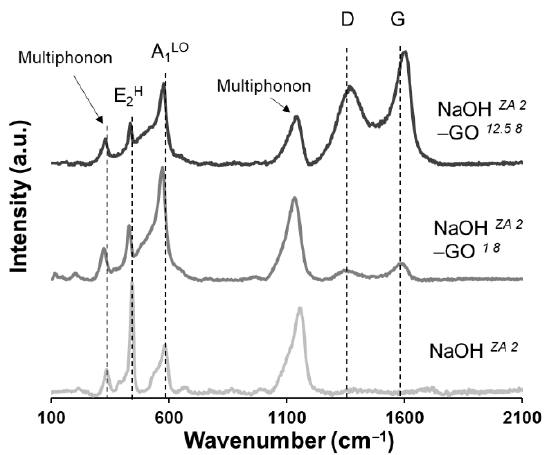
Figure 7. Raman spectra of ZnO (NaOH ZA 2 ) and ZnO – rGO composites with the addition of differ- ent GO concentration: 1 mg/mL (NaOH ZA 2 – GO 1 8 ) and 12.5 mg/mL (NaOH ZA 2 – GO 12.5 8 ).